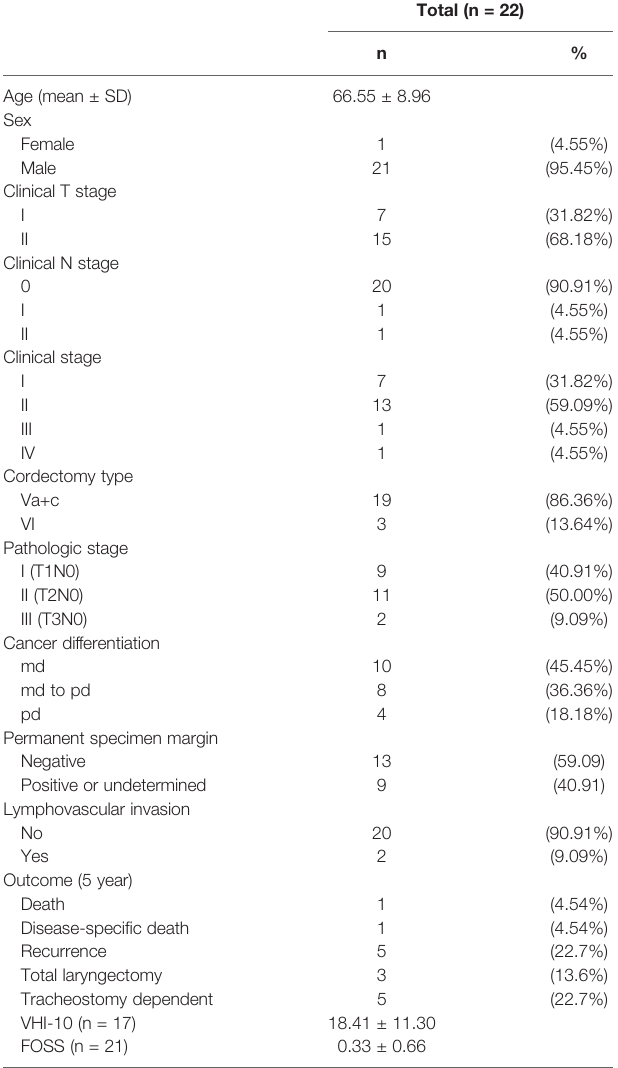
TABLE 1 | The summarized data of overall 22 patients and their